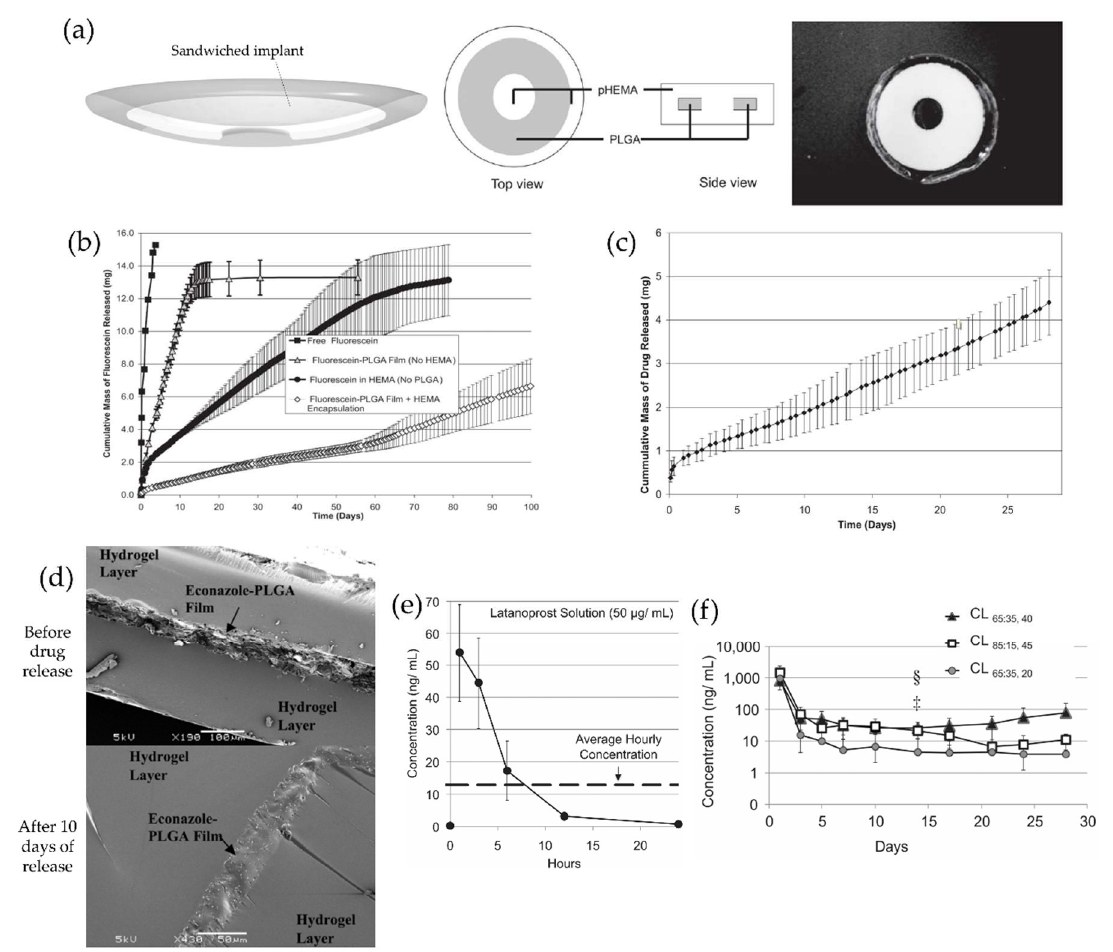
Figure 4. ( a ) Schematic of a therapeutic contact lens embedded with sandwiched polymeric implant (left, middle) and photograph (right) of a ciprofloxacin-loaded PLGA implant-embedded poly-HEMA-contact lens with a 5-mm clear central zone; ( b ) Cumulative drug release profiles for 100 days from free fluorescein powder, fluorescein-PLGA films, fluorescein-coated poly-HEMA-contact lens and poly-HEMA-contact lens embedded with fluorescein-PLGA films; ( c ) Ciprofloxacin release from PLGA implant-embedded contact lenses in vitro. Reprinted with permission from [63]; ( d ) SEM images (X190) of econazole-PLGA films within prototype contact lenses made of poly-HEMA hydrogel in before drug release (up) and in after 10 days of release (down). Reprinted with permission from [64]; ( e ) Concentration of latanoprost in aqueous humor after topical instillation of latanoprost solution (50 μg/mL); ( f ) Concentrations of latanoprost in aqueous humor in rabbits wearing latanoprost-eluting contact lenses. Reprinted with permission from [65].